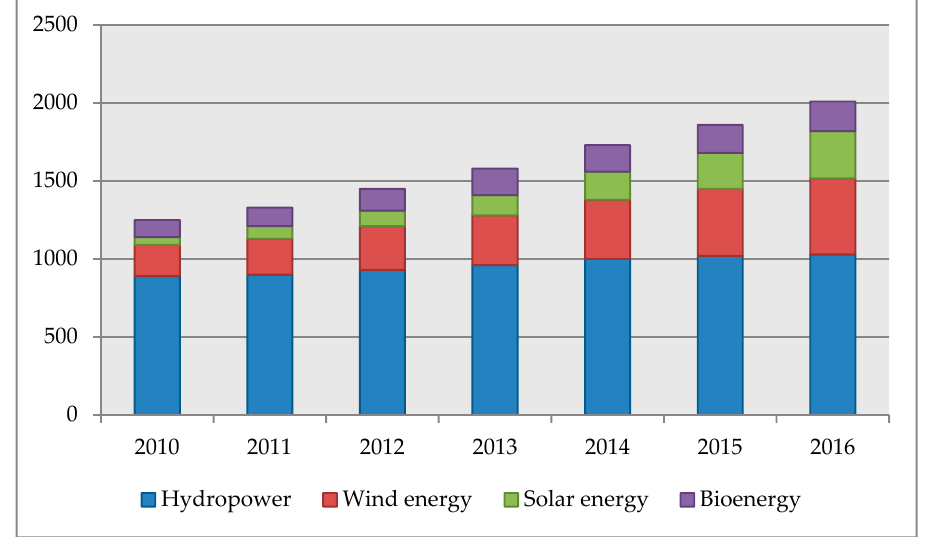
Figure 1. World production capacity of renewable energy sources, GW.